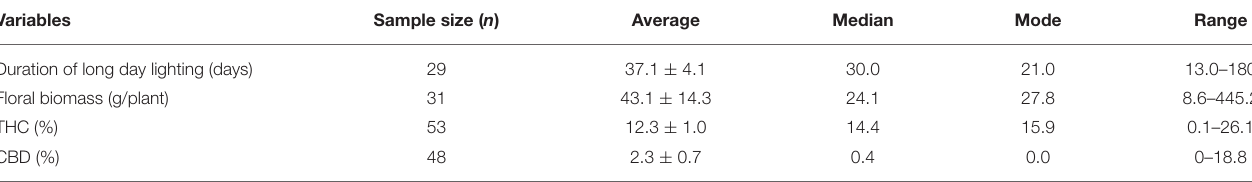
TABLE 1 | Characteristics of photoperiod regimens and yield outcomes (floral biomass, % THC, % CBD) for C. sativa across studies (26 unique studies, including outliers).